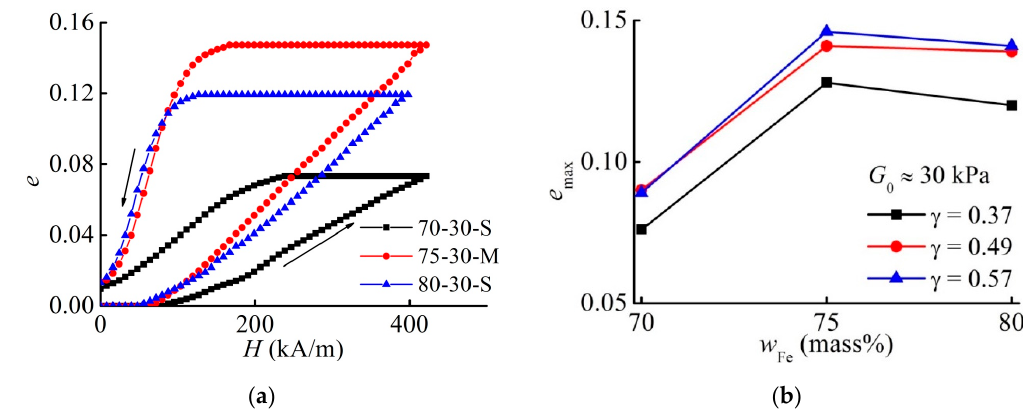
Figure 6. ( a ) Field dependence of the engineering normal strain of MAE samples with the shear modulus of 30 kPa and the aspect ratio of ≈ 0.37. ( b ) Dependence of the maximum strain e max on the mass fraction of iron particles for different aspect ratios for materials with the same shear modulus of 30 kPa.